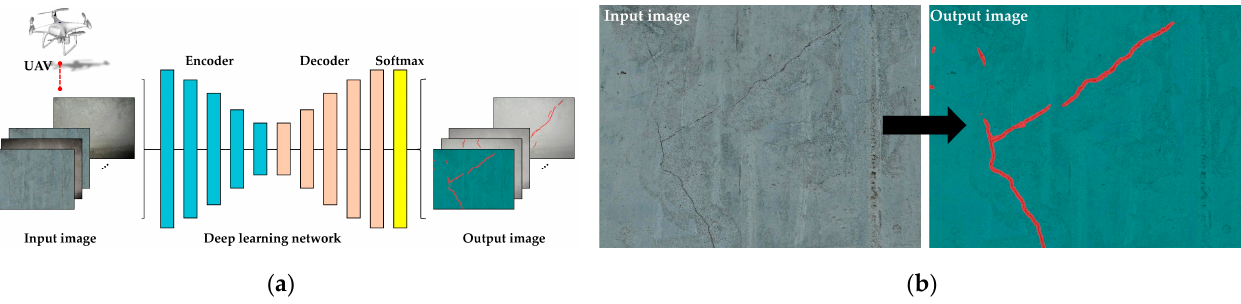
Figure 5. Deep learning-based automated damage detection: ( a ) network architecture; ( b ) automated damage detection result.